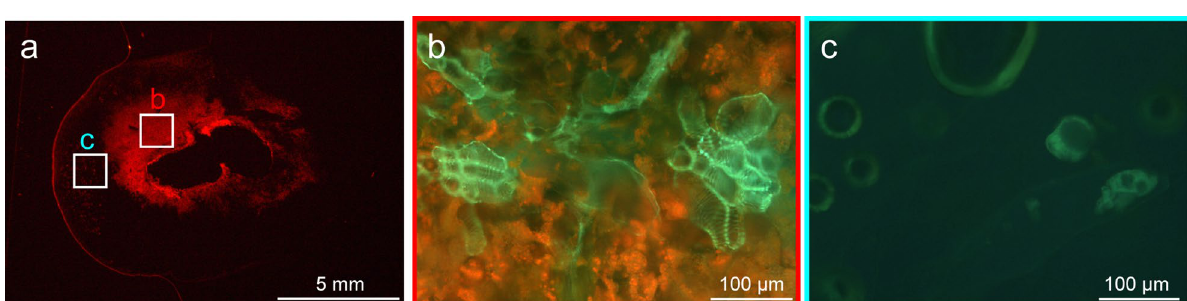
Figure 3. Gross and histological appearance of the weevil-induced gall. Gall in the mature stage. ( a ) whole gall, ( b ) transverse sections of the gall, ( c ) fluorescent image of inner tissue, and ( d ) outer tissue stained with Calcofluor.